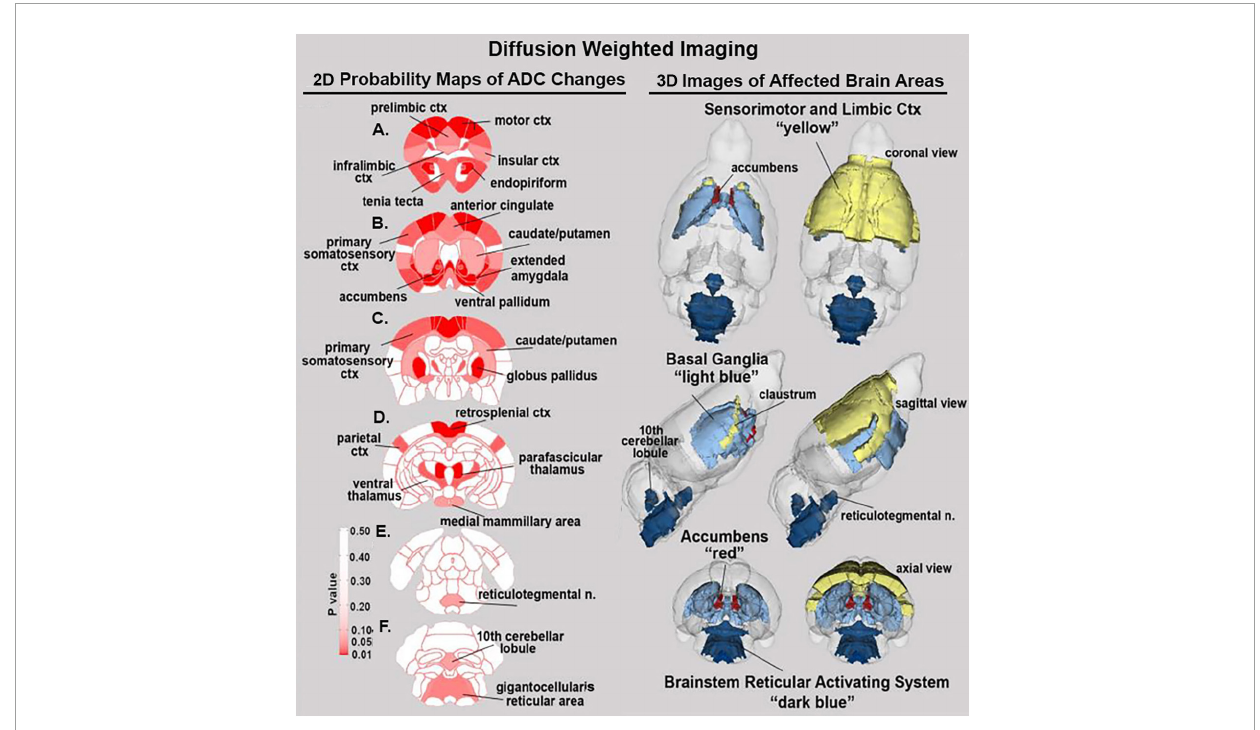
FIGURE2 Diffusion weighted imaging. The location of many of the brain areas listed in Table 2 are shown in the 2D heat maps and are summarized in the 3D color-coded reconstructions to the